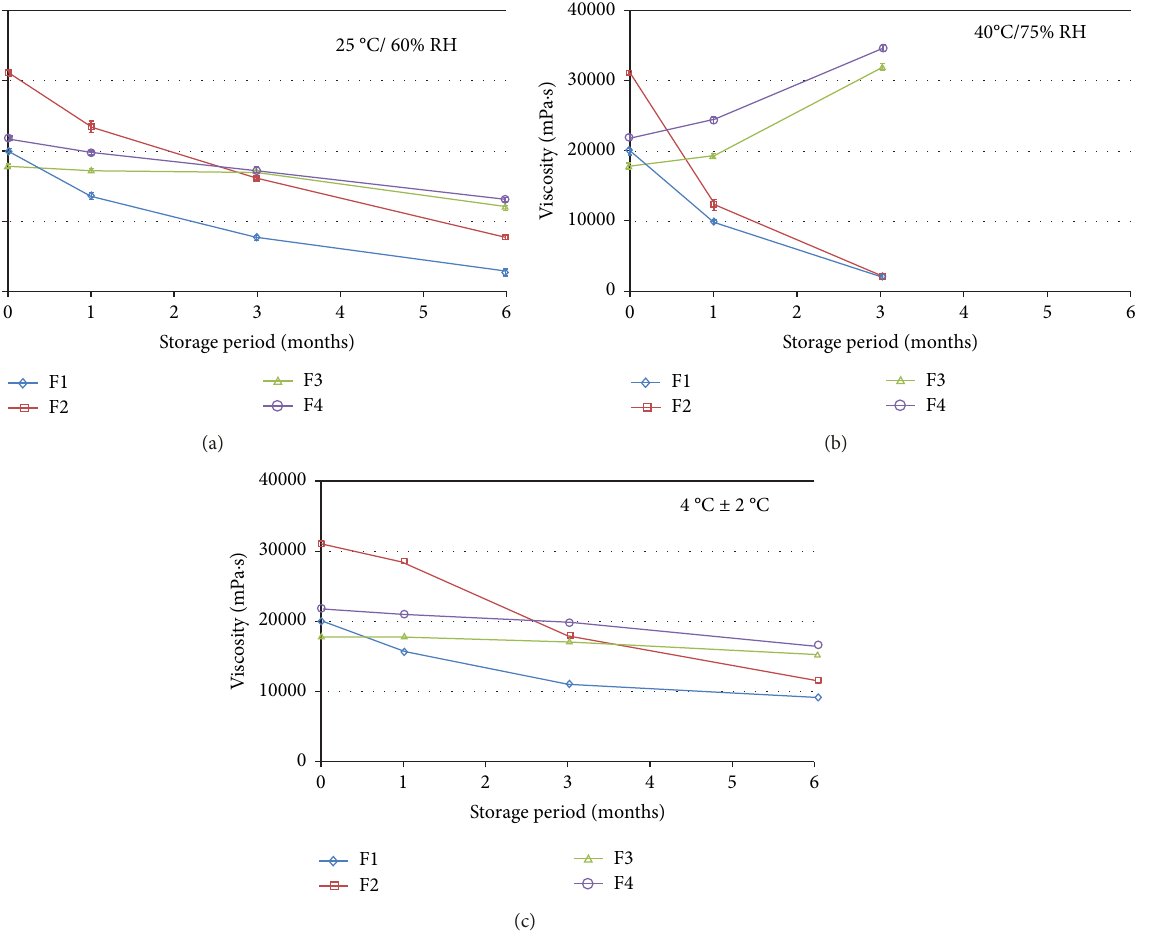
Figure 2: Variations in viscosity values of hydrogels with unmodi fi ed CS (F1, F2) or with bGP-crosslinked CS (F3, F4) upon storage at ambient (a), accelerated (b), and refrigerated conditions (c); n = 3 , mean ±